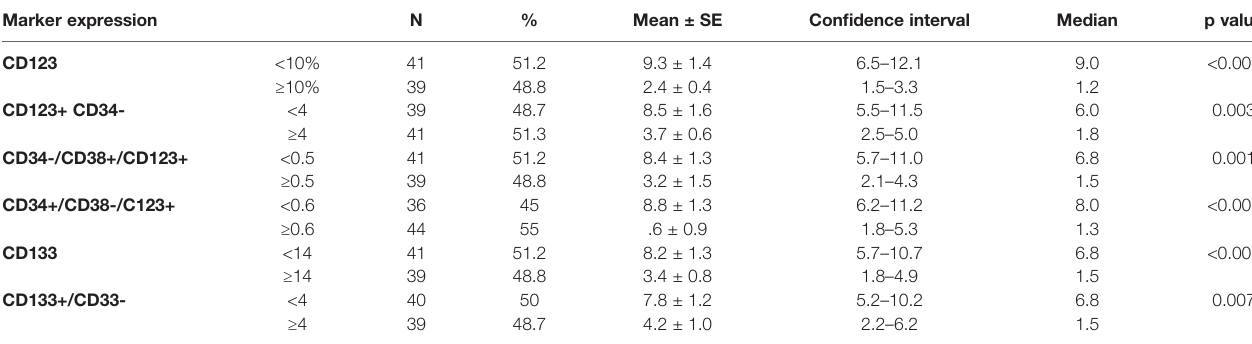
TABLE 4 | Impact of leukemia stem cell frequency at diagnosis on disease-free survival in 80 adult acute myeloid leukemia patients. Marker expression N % Mean ± SE Con fi dence interval